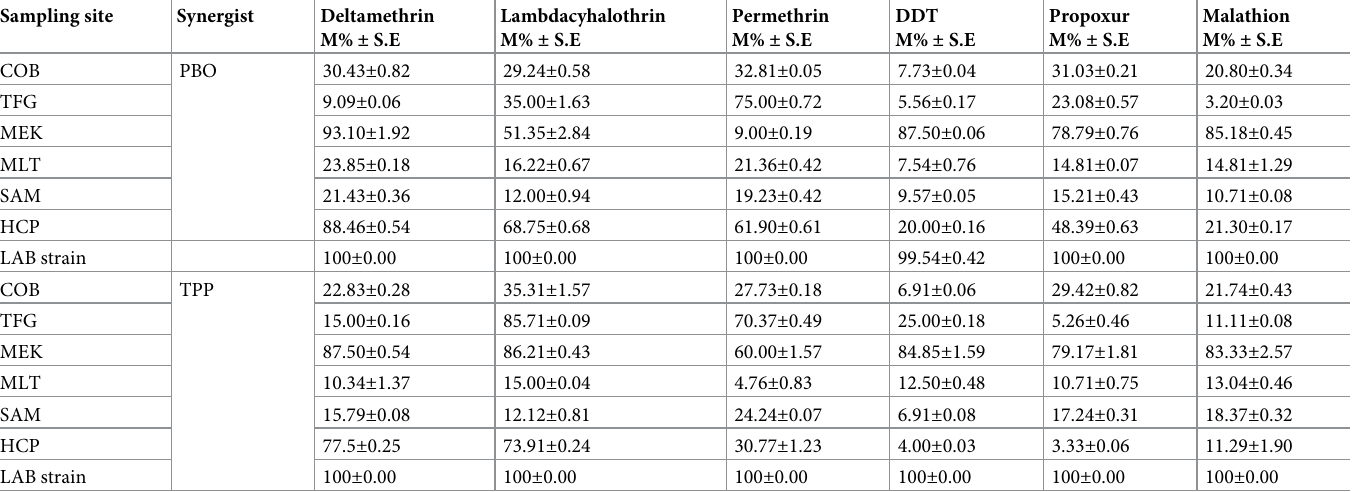
Table 4. Mortality rate (in percent) of Cx . quinquefasciatus populations after exposure to synergists and insecticides. Sampling site